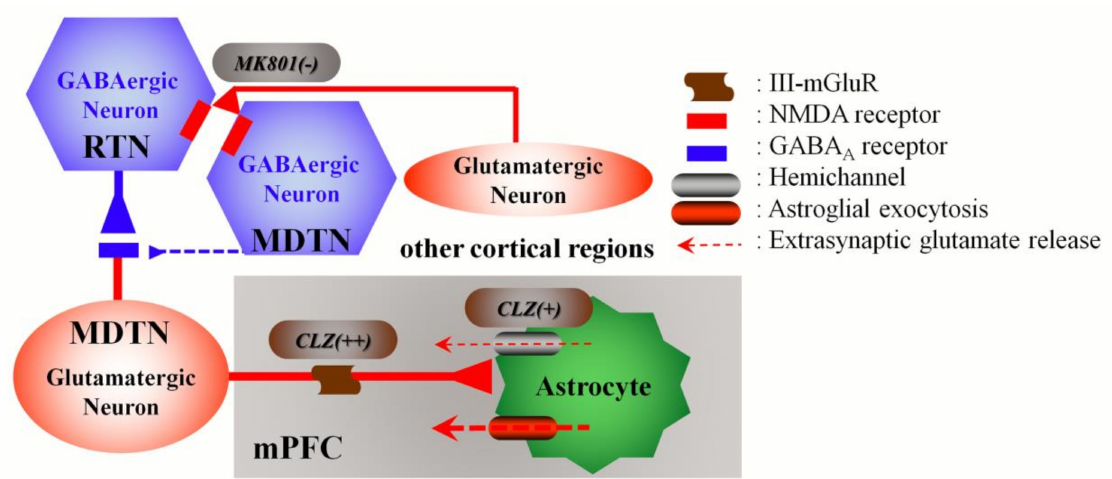
Figure 8. Our proposed hypothesis for the extended neural circuitry involved in thalamocortical (RTN–MDTN–mPFC) glutamatergic transmission. Glutamatergic neurons in the MDTN (red circle), which receive GABAergic terminals from RTN [22,23] and other MDTN regions, project to mPFC [21]. Inhibitory GABAergic regulation of MDTN glutamatergic neurons from the RTN is predominant rather than regulation of those from the MDTN. MK801 inhibits the actions of tonically active NMDA-R (red squares) on GABAergic neurons (blue hexagon) in the RTN and the MDTN. Inhibition of NMDA-R in GABAergic neurons leads to disinhibition of MDTN glutamatergic neurons. The GABAergic disinhibition activates MDTN glutamatergic neuronal activity, resulting in an increase in glutamate release in the mPFC. CLZ increased l -glutamate release in the mPFC via astroglial and pre-synaptic regulation mechanisms. Therapeutically relevant concentrations of CLZ activates the function of pre-synaptic III-mGluRs (brown wave) and extra-synaptic astroglial exocytosis (red ellipse) [28] in the mPFC region. Toxic concentrations of CLZ activates hemichannel (gray ellipse) activity. CLZ prevents hyperactivated MDTN–mPFC glutamatergic transmission via activation of inhibitory pre-synaptic